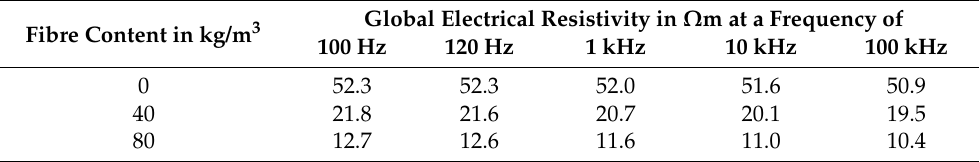
Table A50. Results of the resistivity measurements of the concrete mixture 32-60-300-00 after storage in synthetical pore solution for 56 days for the investigations of possible leaching effects.